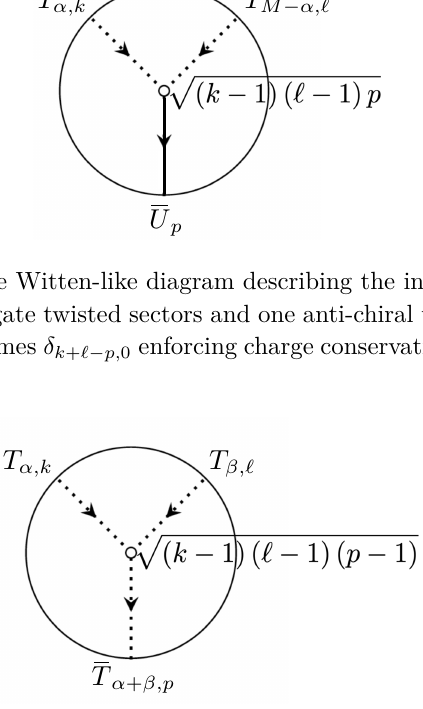
Figure 5 . A cubic interaction involving three twisted operators whose twist parameters add up to zero modulo M . The cubic vertex is p ( k − 1) ( ‘ − 1) ( p − 1) times δ conservation. Again this δ -function is